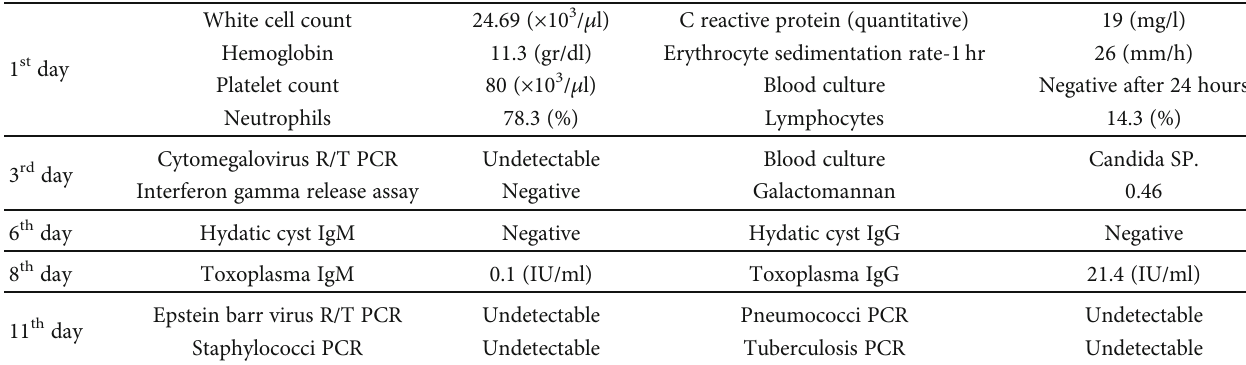
Table 2: Intensive care unit laboratory